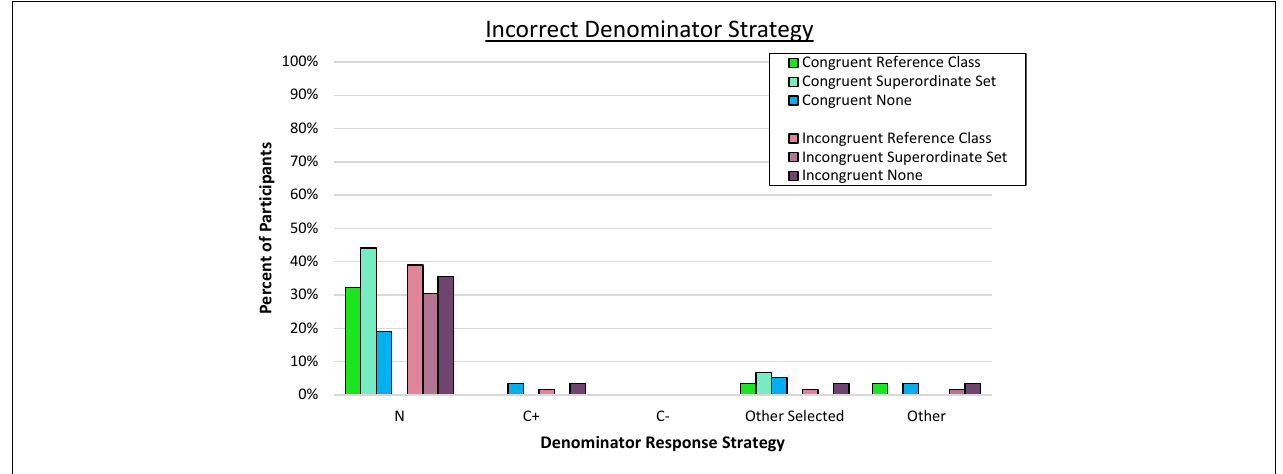
FIGURE 6 | Proportion of participants who consistently used the incorrect denominator strategy on the frequency response format. N denotes the total in the superordinate set (i.e., sample size), C ± denotes the total number of people who have or do not have the condition.